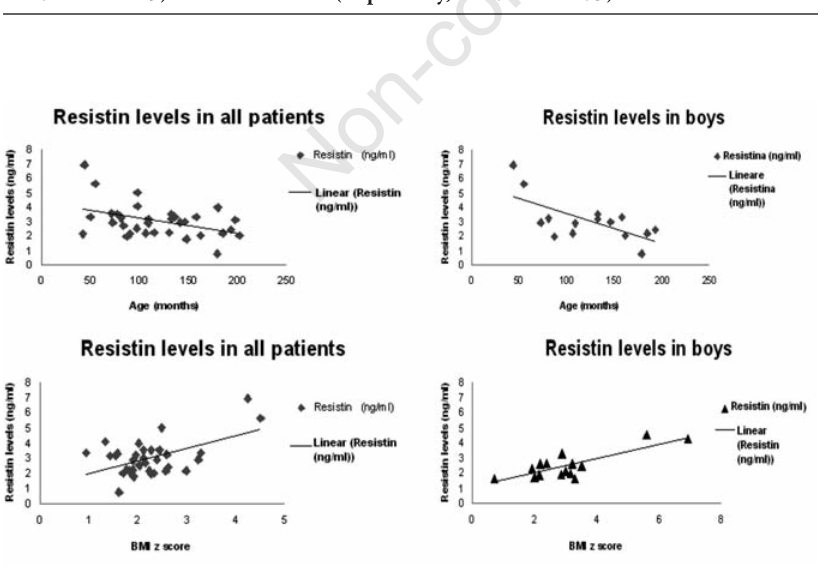
Figure 1. Correlation between plasma leptin levels and age (months) or BMI z score. In all patients and particularly in girls leptin levels are in correlation with age (respectively, r=0.30 and r=0.5) and BMI z score (respectively, r=0.31 and 0.35).